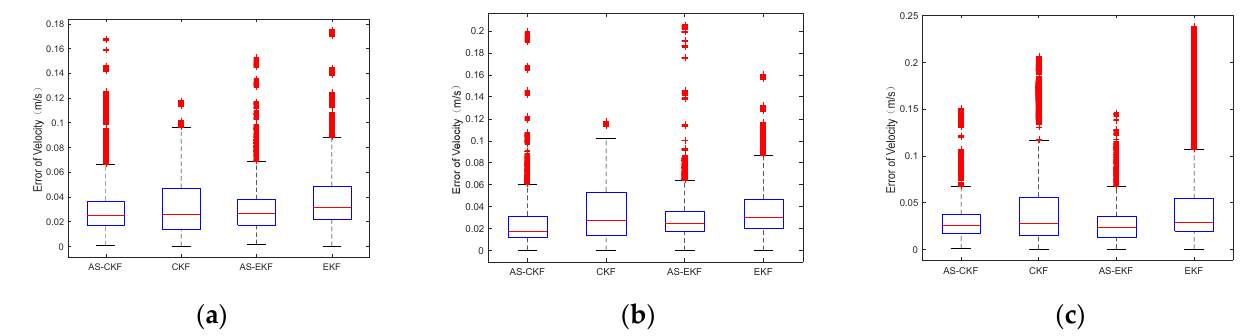
Figure 12. Velocity error boxplots of different algorithms under different delay conditions: ( a ) rep ‐ resents the time delay τ = 20 ms, ( b ) represents the time delay τ = 40 ms, and ( c ) represents the time delay τ = 100 ms.